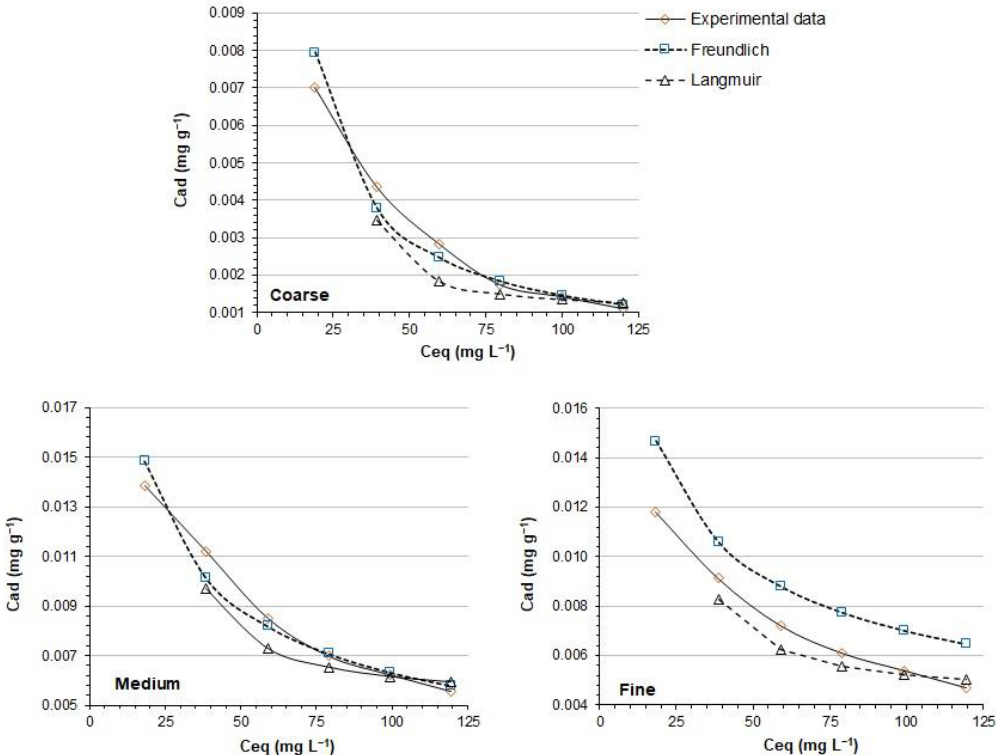
Figure 8. Adsorption isotherms for nitrate ions on the adsorbent substrates prepared with the three granulometric fractions of material and activated with H 2 SO 4